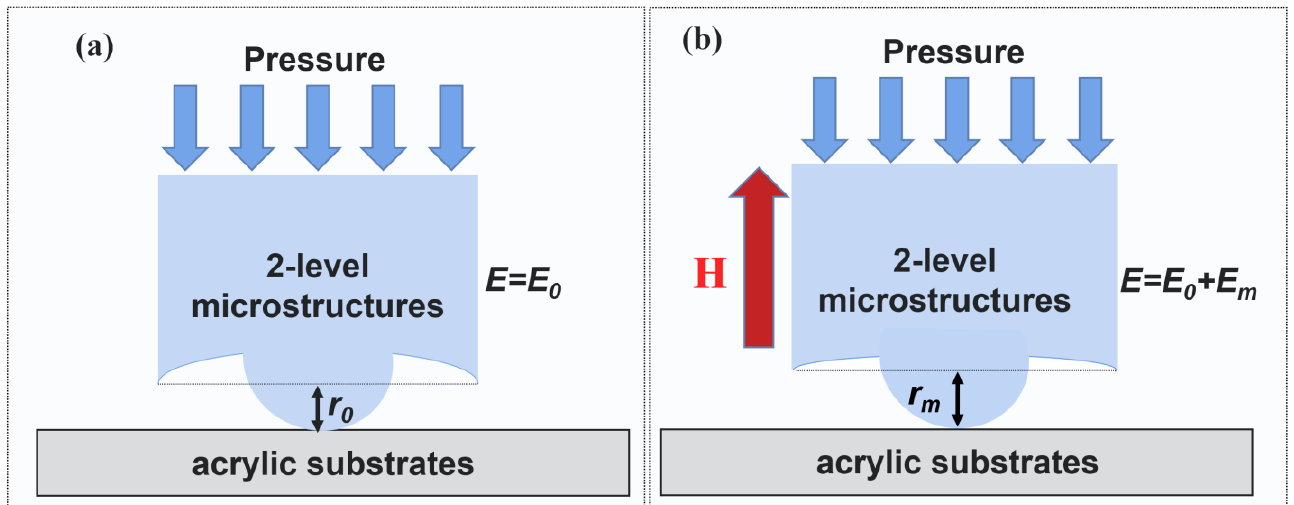
Figure 6. The mechanism of the magneto-responsive adhesion of 2L-MAE detached from dry acrylic substrates. ( a ) the pull-off process without a magnetic field in mesoscopic ( b ) the pull-off process with a magnetic field in microscopic.